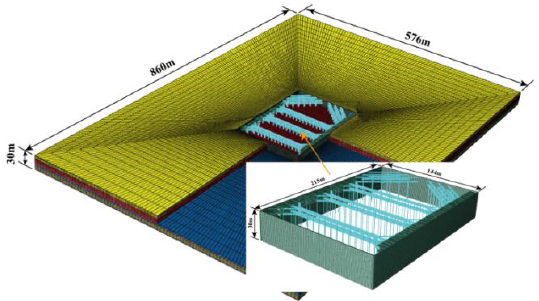
Figure 4. Numerical model of foundation pit braced by section steel assembly. Table 2. Physical and mechanical parameters of steel assembly bracing.